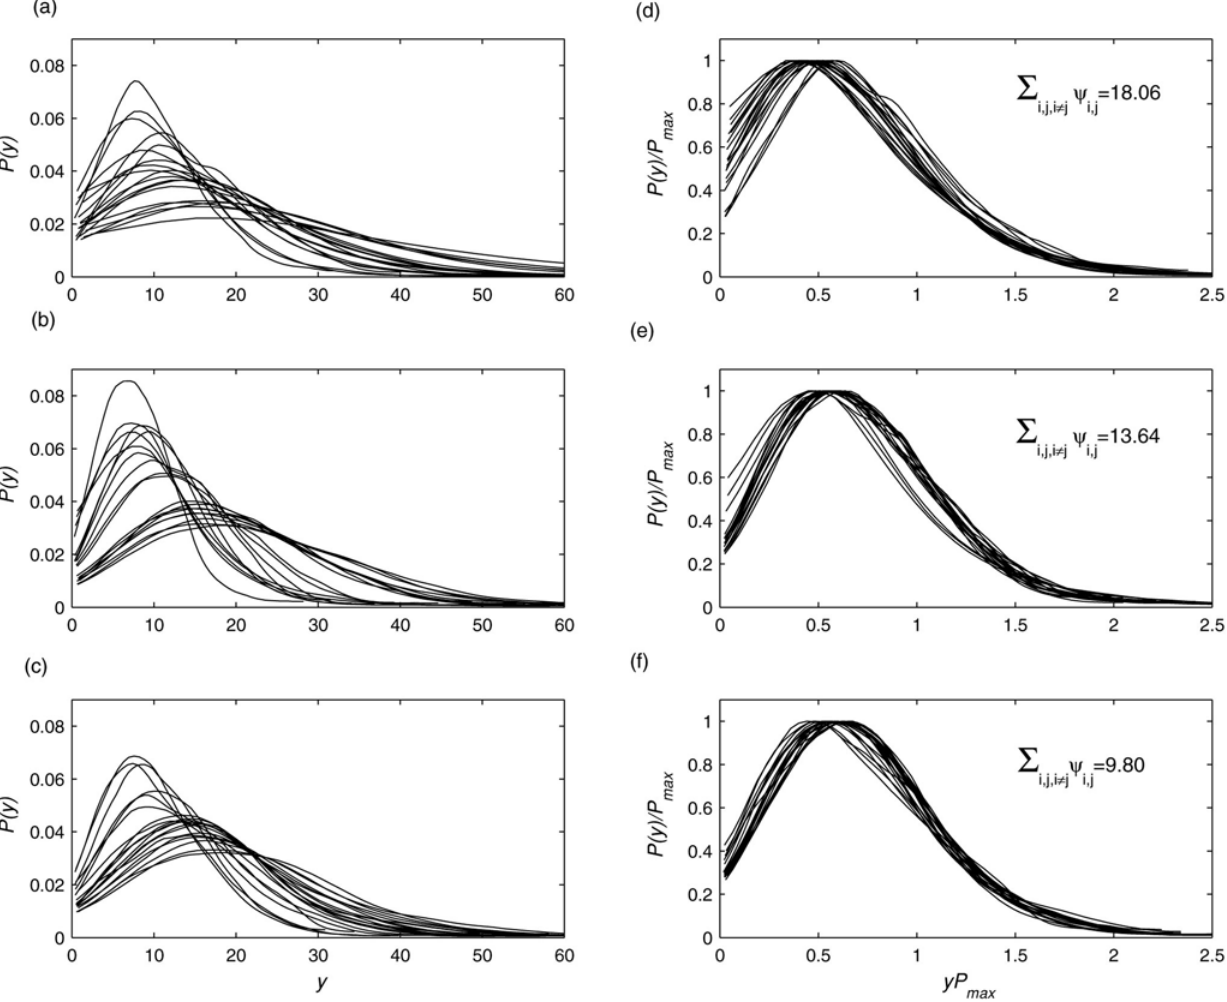
Figure 2. Universality across brain regions for all participants. Empiriical probability density functions P ( y ) of the envelope of wavelet transformed coefficients at scale a =2 for multivariate EEG signals recorded from 19 scalp locations from a participant (Vp.483) during (a) resting condition, (b) perception of a visual art object, and (c) mental imagery of the same art object. All pdfs were normalized to unit area. (d–f) Same pdfs are in (a–c) but after rescaling: P ( y ) by P max and y by 1/ P max to preserve the normalization to unit area. The values in inset indicate the degree of data collapsing as measured by the KL divergence measure (see the text for details). Lower divergence or higher data collapse was found during mental